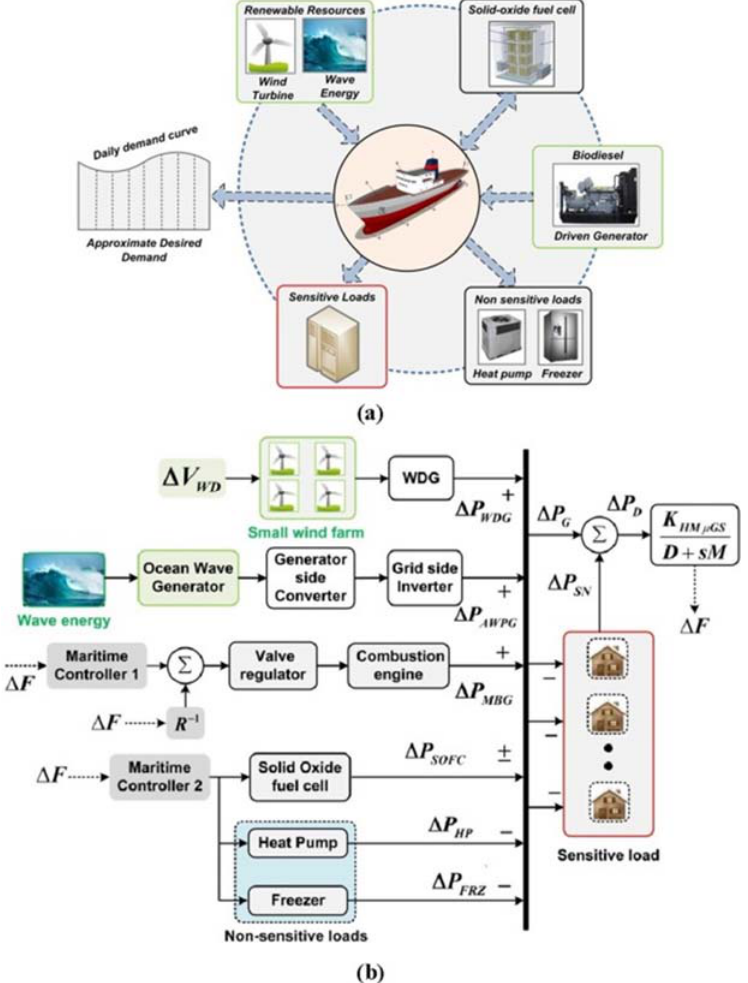
Figure 6. A marine microgrid with Renewable Energy and loads. ( a ) microgrid topology ( b ) control design